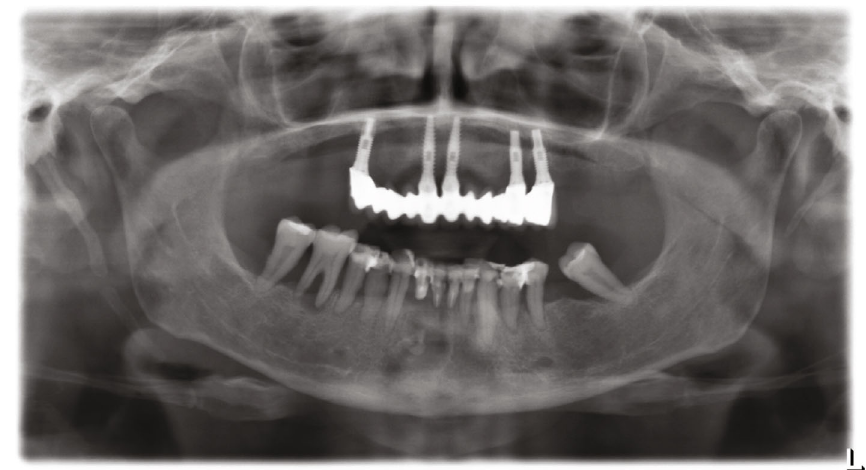
Figure 3: Orthopantomography performed in 2019.